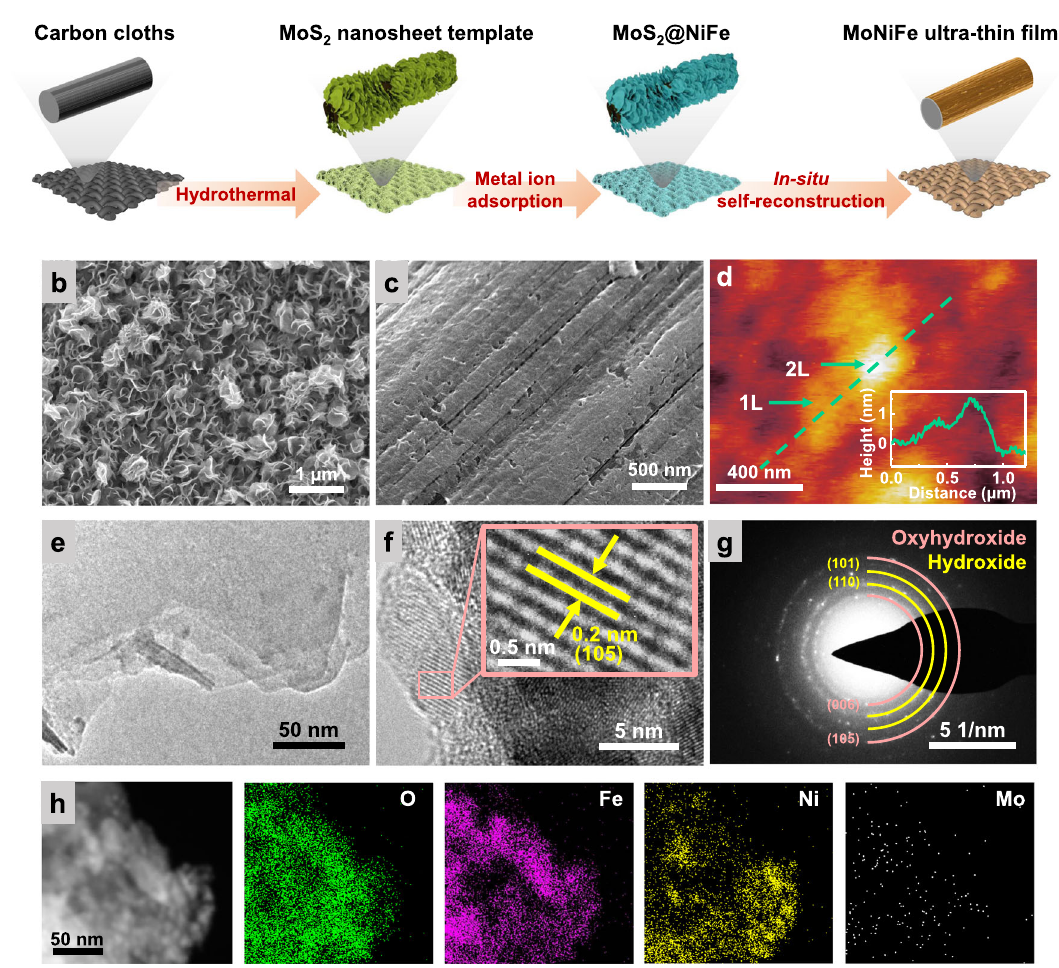
Fig. 1 Preparation and characterizations of the MoNiFe (oxy)hydroxide. a Schematic illustration of the preparation process of the MoNiFe (oxy) hydroxide. Scanning electron microscopy (SEM) images of b the MoS 2 nanosheet template and c MoNiFe (oxy)hydroxide. d Atomic force microscopy (AFM) image of the MoNiFe (oxy)hydroxide fl akes. The inset fi gure is the corresponding line-trace height pro fi le across a MoNiFe (oxy)hydroxide fl ake. High-resolution transmission electron microscopy (HRTEM) images with e low magni fi cation and f high magni fi cation, g selected area electron diffraction (SAED) pattern and h energy dispersive spectroscopy (EDS) mapping for the MoNiFe (oxy)hydroxide with Ni:Fe ratio of 73: